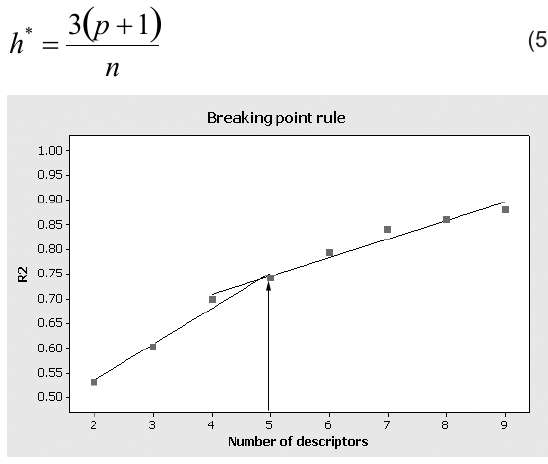
Figure 2. Breaking point rule for determination of optimal number of descriptors (R 2 of the models vs. number tr of